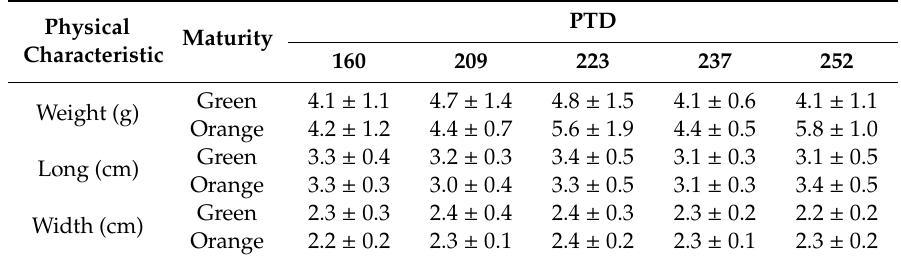
Table A2. Average of weight, length and width of the immature (green) and mature (orange) Habanero peppers on each of the di ff erent